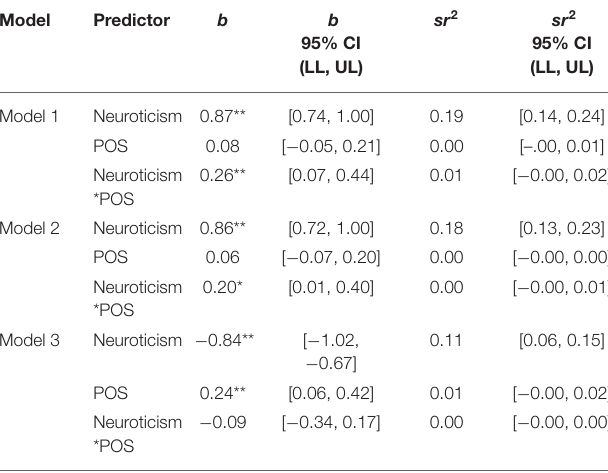
b Represents unstandardized regression weights. sr 2 represents the semi-partial correlation squared. LL and UL indicate the lower and upper limits of a confidence interval, respectively. * Indicates p < 0.05. ** Indicates p < 0.01. EE, emotional exhaustion; DE, depersonalization; RPA, reduced